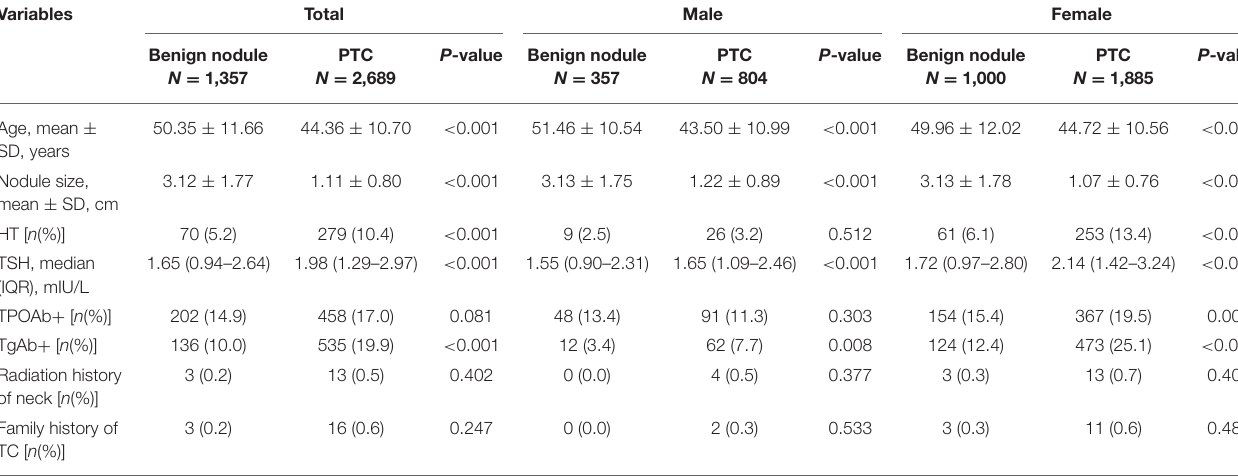
TABLE 1 | Characteristics of patients with benign nodule and PTC in different genders. Variables